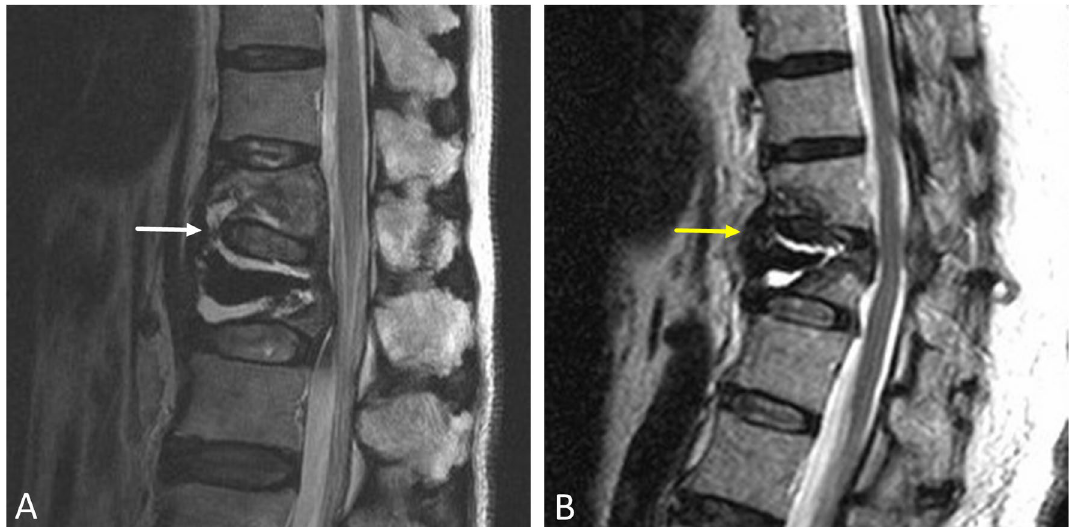
Figure 3. Preoperative MRI predictors of the cement bridging phenomenon include ( A ) fluid accumulation (white arrow) and ( B ) hypointense signaling (yellow arrow), indicating a redundant anterior longitudinal ligament, around the space anterior to the abutting vertebral bodies and the corresponding intervertebral